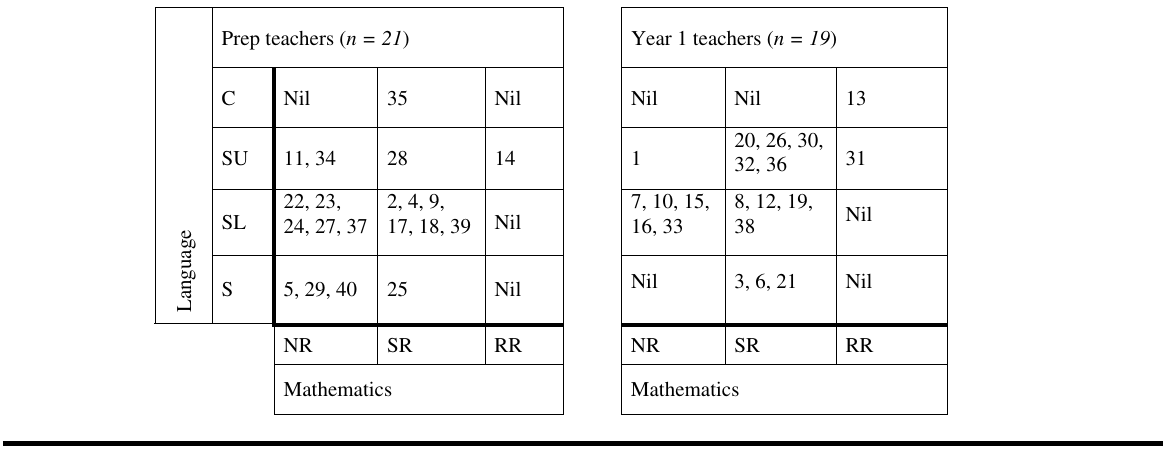
Plot mapping oral language use and degree of mathematical representation — teachers at multicultural schools (n= 17).